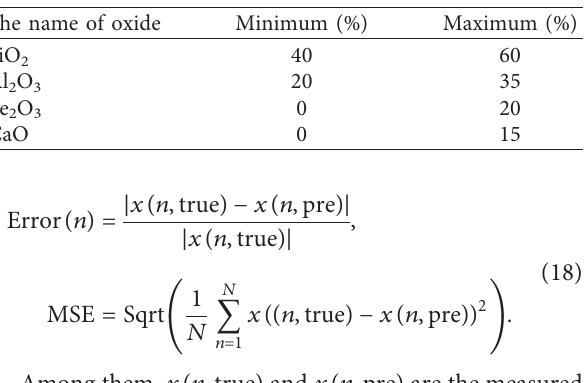
Table 4: Value range of different oxide content in coal gangue for training